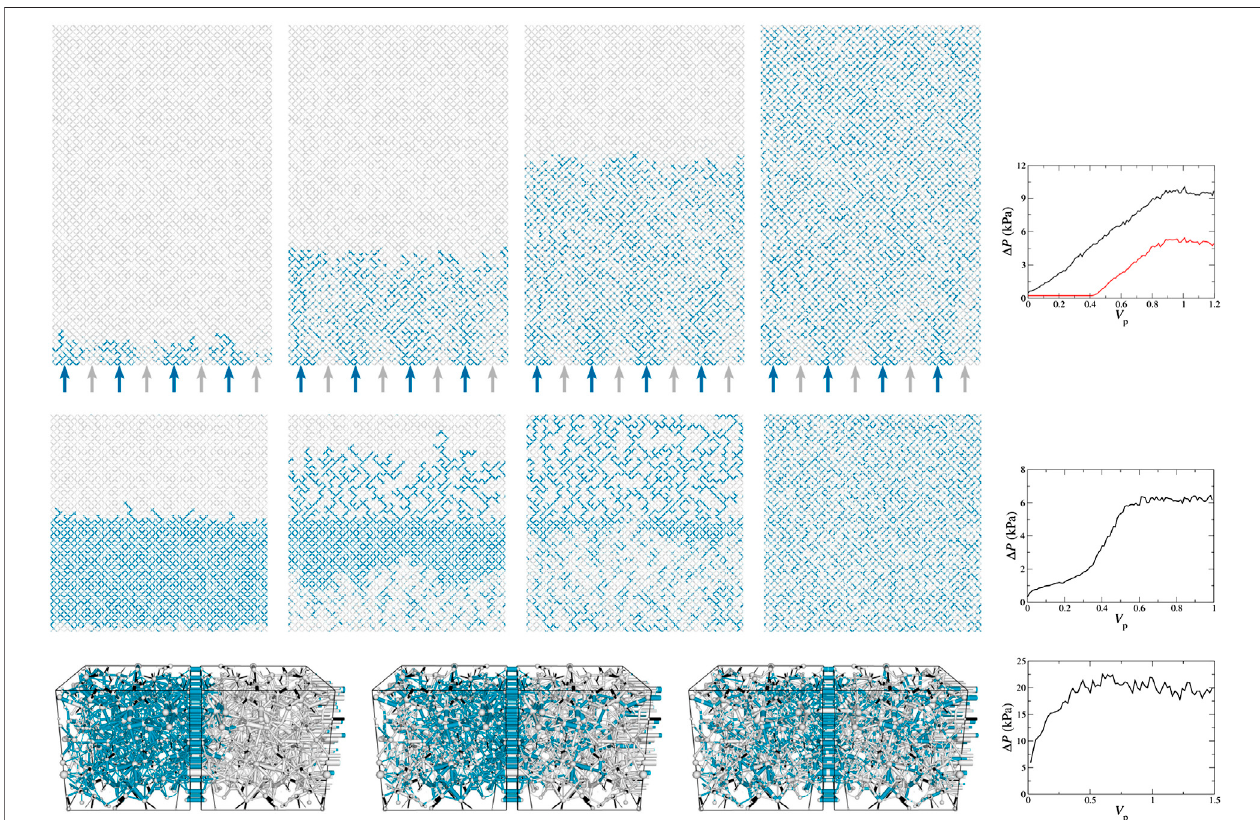
FIGURE 10 | Steady-state simulations at Ca (cid:1) 0 . 001 and M (cid:1) 1 with different boundary conditions. The wetting and non-wetting fl uids are colored by gray and blue. Thetoprow showssimulation withopen boundary at F w (cid:1) 0 . 5witha2Ddiamond networkof64 × 100links.Thenexttworowsrespectivelyshow simulations with periodic boundary for S w (cid:1) 0 . 5witha2Dnetworkof64 × 64 linksand with a3Dreconstructed networkofBerea sandstone.Thedirectionsofthe overall fl owisfrom the bottom to top for 2D simulations and from the left to right for 3D simulations. For each system, the measured global pressure drops ( Δ P ) as a function of the pore volumes ( V p ) of fl uids passed are shown at the right where the red and black curves for the fi rst system show the pressure drops at the middle and at the inlet of the system with respect to the outlet row.